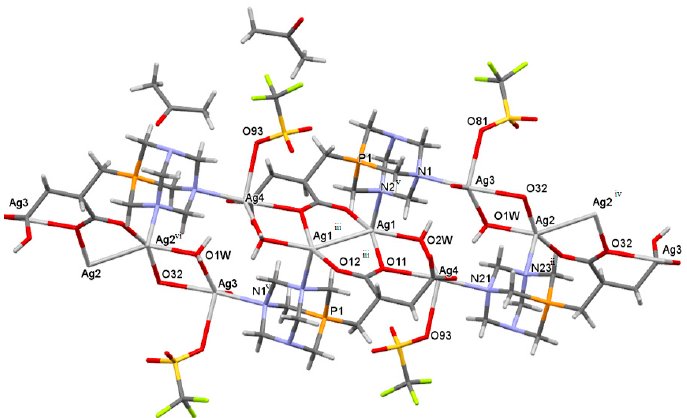
Figure 9. Partial packing view of CP2 . Selected bond lengths (Å): Ag1–O2W = 2.383(4), Ag1–O11 = 2.319(5), Ag1–Ag1 (iii) = 2.8315(6), Ag1–O12 (iii) = 2.253(5), Ag1–N2 (v) = 2.480(6), Ag2–O1W = 2.377(4), Ag2–O31 = 2.241(5), Ag2–O32 = 2.301(5), Ag2–N23 (ii) = 2.493(6), Ag2–Ag2 (iv) = 2.8310(6), Ag3–O1W = 2.357(6), Ag3–O32 = 2.668(4), Ag3–O33 = 2.342(6), Ag3–O81 = 2.584(3), Ag3–N1 (v) = 2.458(6), Ag3–O42 = 2.672(4), Ag4–O2W = 2.351(6), Ag4–O11 = 2.672(4), Ag4–O41 = 2.343(6), Ag4–O93 = 2.609(9), Ag4– N21 = 2.449(6), Ag1–Ag4 = 3.651, Ag2–Ag3 = 3.641, [Symmetry codes: (ii) 1 + x,y,z, (iii) –x,1 – y, – z, (iv) 1 – x,1 – y,–1-z (v) 1 – x,1 – y,–z ].